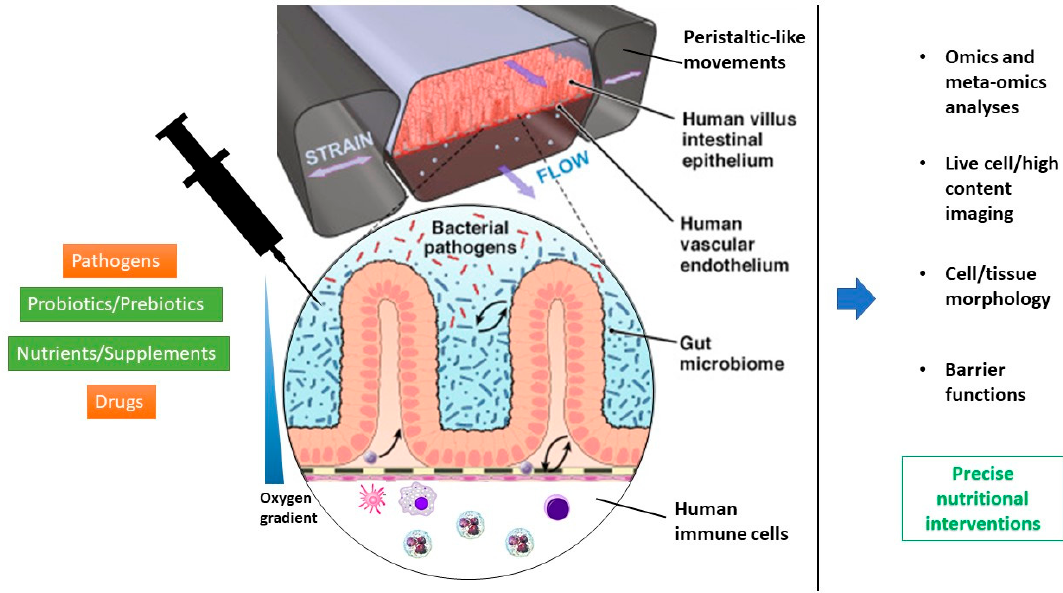
Figure 2. Scheme of a human gut-on-a-chip and its potential applications in the study of the interaction between the microbiome, infectious diseases, and nutrition.